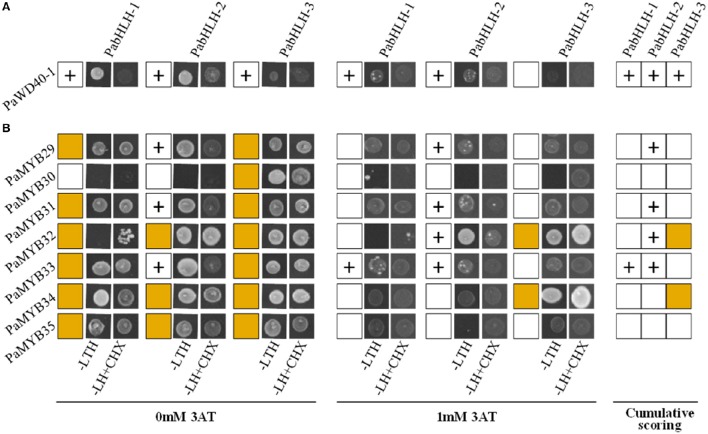
Interaction of P. abies proteins using yeast-two-hybrid (Y2H). (A) Interaction between PaWD40-1 and bHLH proteins. (B) Interaction between bHLH and MYB transcription factors. Plus sign (+) indicates positive interaction between a protein pair tested at 0 mM 3-Amino-1,2,4-triazole (3AT) or 1 mM 3AT. Brown box indicates autoactivations at both 0 mM 3AT or 1 mM 3AT conditions. Cumulative scoring encompasses positive interactions at any given conditions.